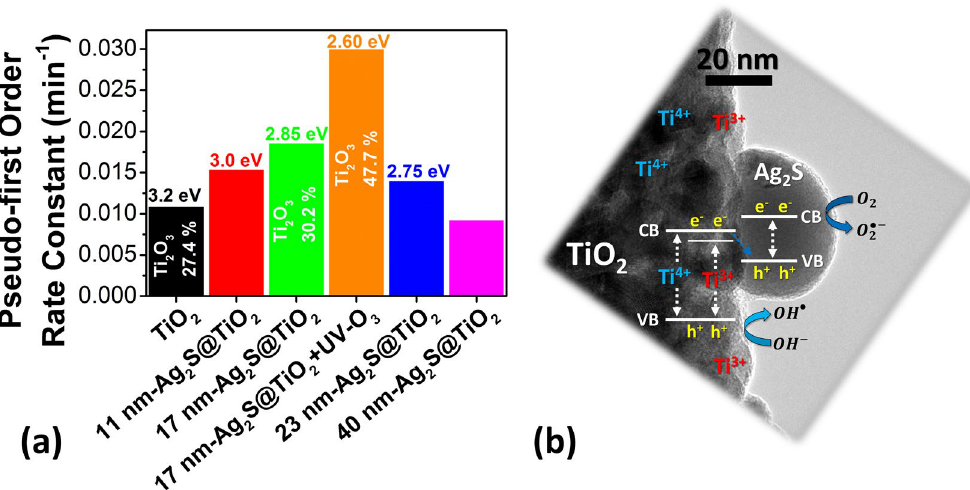
Figure 8. ( a ) Methylene blue photodegradation rate constants for all the samples. Percentage of Ti 2 O 3 surface states (estimated form O 1 s XPS signal) and calculated bandgaps are also listed. ( b ) Schematic of the interfacial charge transfer processes during illumination of Ag 2 S sensitized TiO 2 nanofibers with excess Ti 3 + states and oxygen